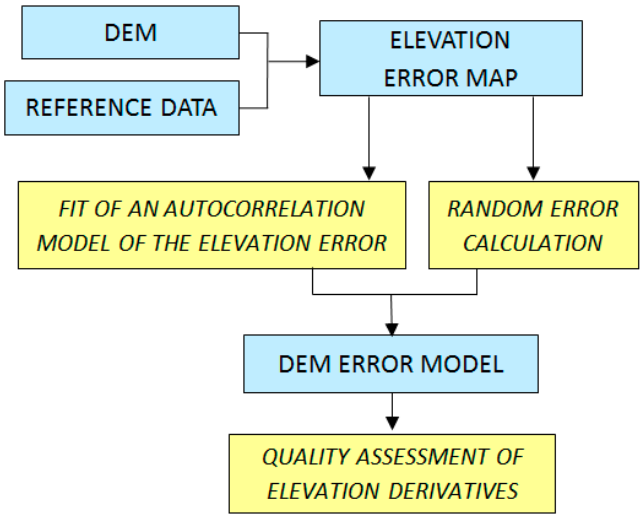
Figure 5. Method for the elaboration of an elevation error model.